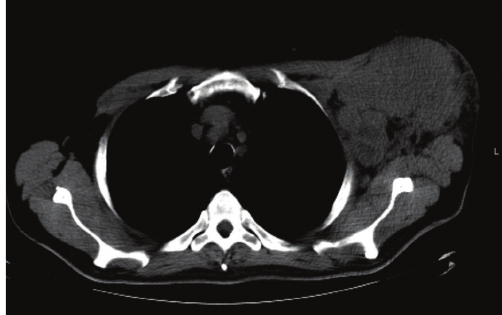
Figure 1: CT scan demonstrating an enlarged lymph node in left axilla with hypodense areas.